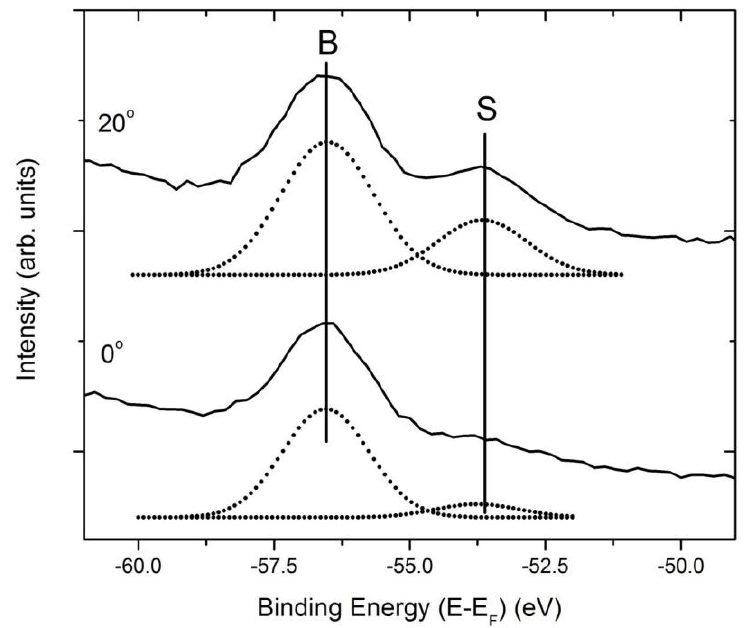
Figure 6. Angle-resolved photoemission spectra of Li Li 1s core level, for photoelectron emission angles of 20° and 0°. In both cases, the in-plane component of E was oriented along [001] with a light incidence angle 45° and with photon energy of 95 eV. The figure shows spectra with the instrumental background and secondary electron tail subtracted from the spectra with fittings to the Li 1s bulk and surface peaks, denoted B (bulk component contribution) and S (surface component contribution), respectively. The sample temperature for these measurements was 623 ± 5 K, to reduce surface charging. Adapted from